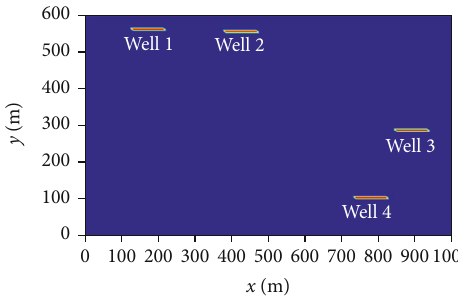
Figure 3: Reservoir model #1 that is used for validation purpose.